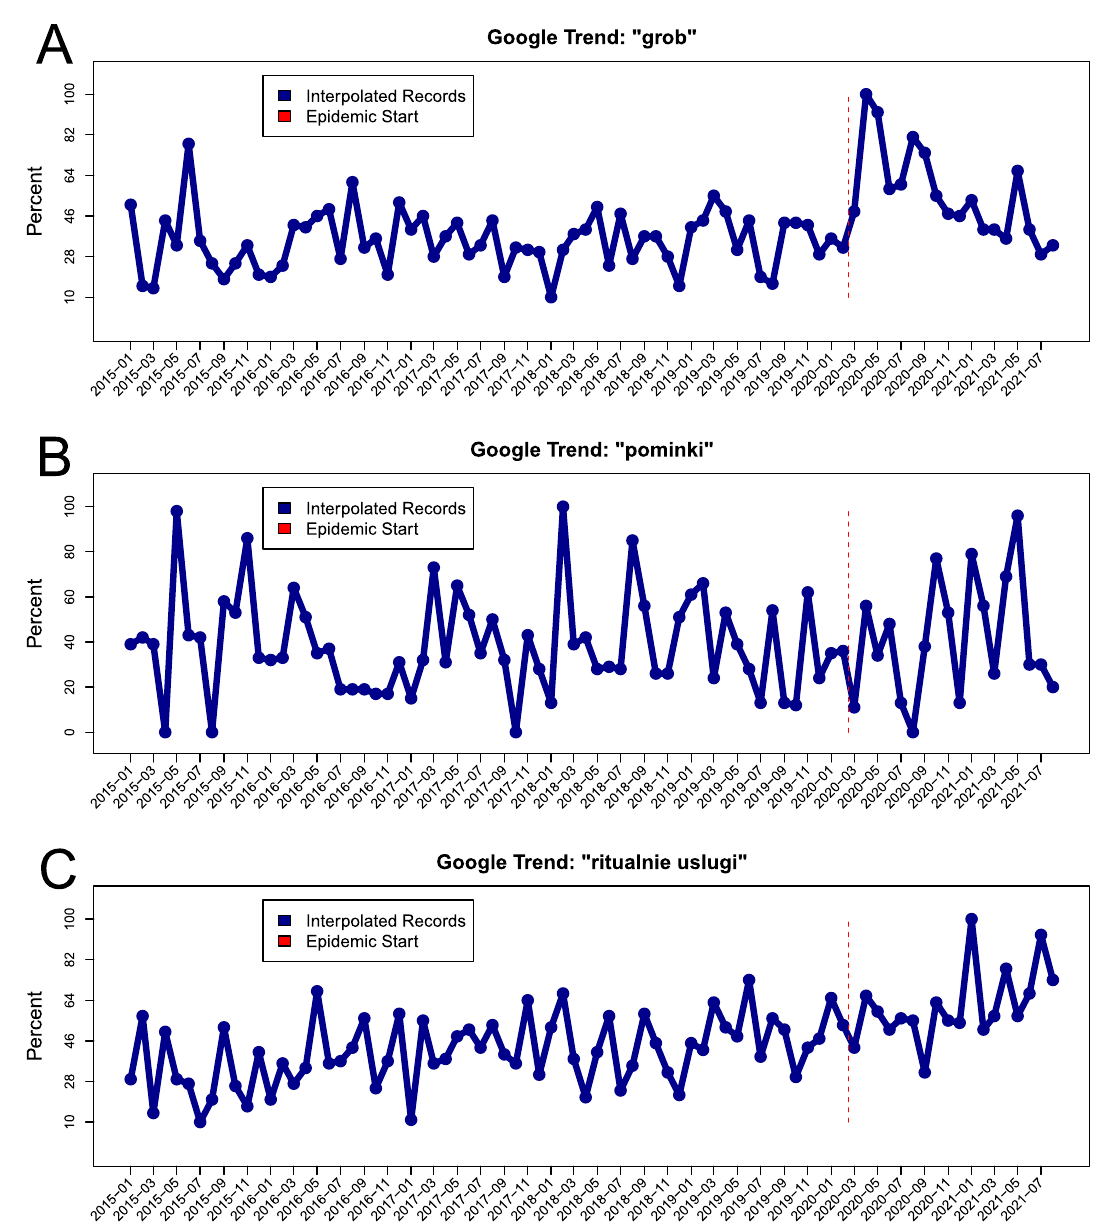
Figure 2. The visual summaries of the monthly raw Google trends data from January 2015 until August 2021 for ( A ) “grob” i.e. coffin, ( B ) ”pominki” i.e. memorial service and ( C ) “ritualnie uslugi” i.e. funeral services. The vertical red bar emphasizes the epidemic start, i.e. time of the first confirmed scores were 31.07% for five and 33.43% for nine years histories. For the models with demographic characteristics (i.e. the number of individuals of age 65 and older) for the latest reported month June the scores were 29.46% for five and 35.59% for nine years histories. The corresponding visual summaries are provided in Supplement Fig. S3 and Fig. S4. In addition to that, the comparisons of the ARIMA model fitting for nine years with and without demographic characteristics are presented in Supplement Fig. S5. In the same way as for the Prophet model there is no indication from such comparisons that the ageing population had an effect on mortality over the past pre-pandemic years while the pandemic period was substantially different from pre-pandemic period. The parametric P -scores for the Google Trends search data based on the Prophet forecasting model are presented in Fig. 6. In the same way as for non-parametric scores the results for P -scores do vary substantially from one key phrase to the other. The key phrase “grob” i.e. coffin had the pronounced excess of 97.1% for April of 2020 and 86.6% for September of 2020. The peak values for coffin were observed in the middle of 2020. The key phrase ”pominki” i.e. memorial service did not have a clear trend over the study period and large variability was observed. The largest score was the excess of 66.91% for October of 2020 and the smallest score was the shortage of − 100% for August of 2020. Finally, the key phrase “ritualnie uslugi” i.e. funeral services had the pronounced excess of 95.40% for January of 2021. In summary: (1) the excess of parametric P -scores was observed during